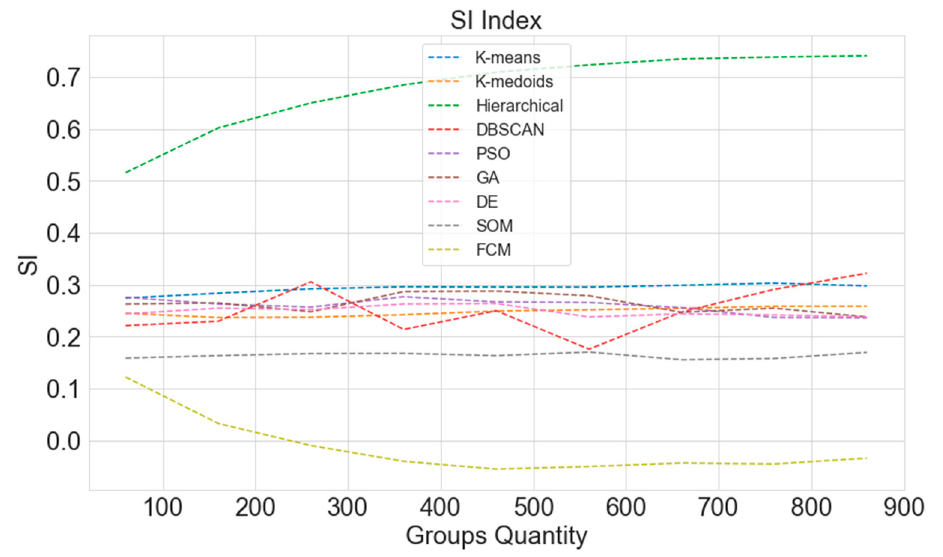
Figure 11. SI index evaluation over different group amounts considering nine clustering methods.